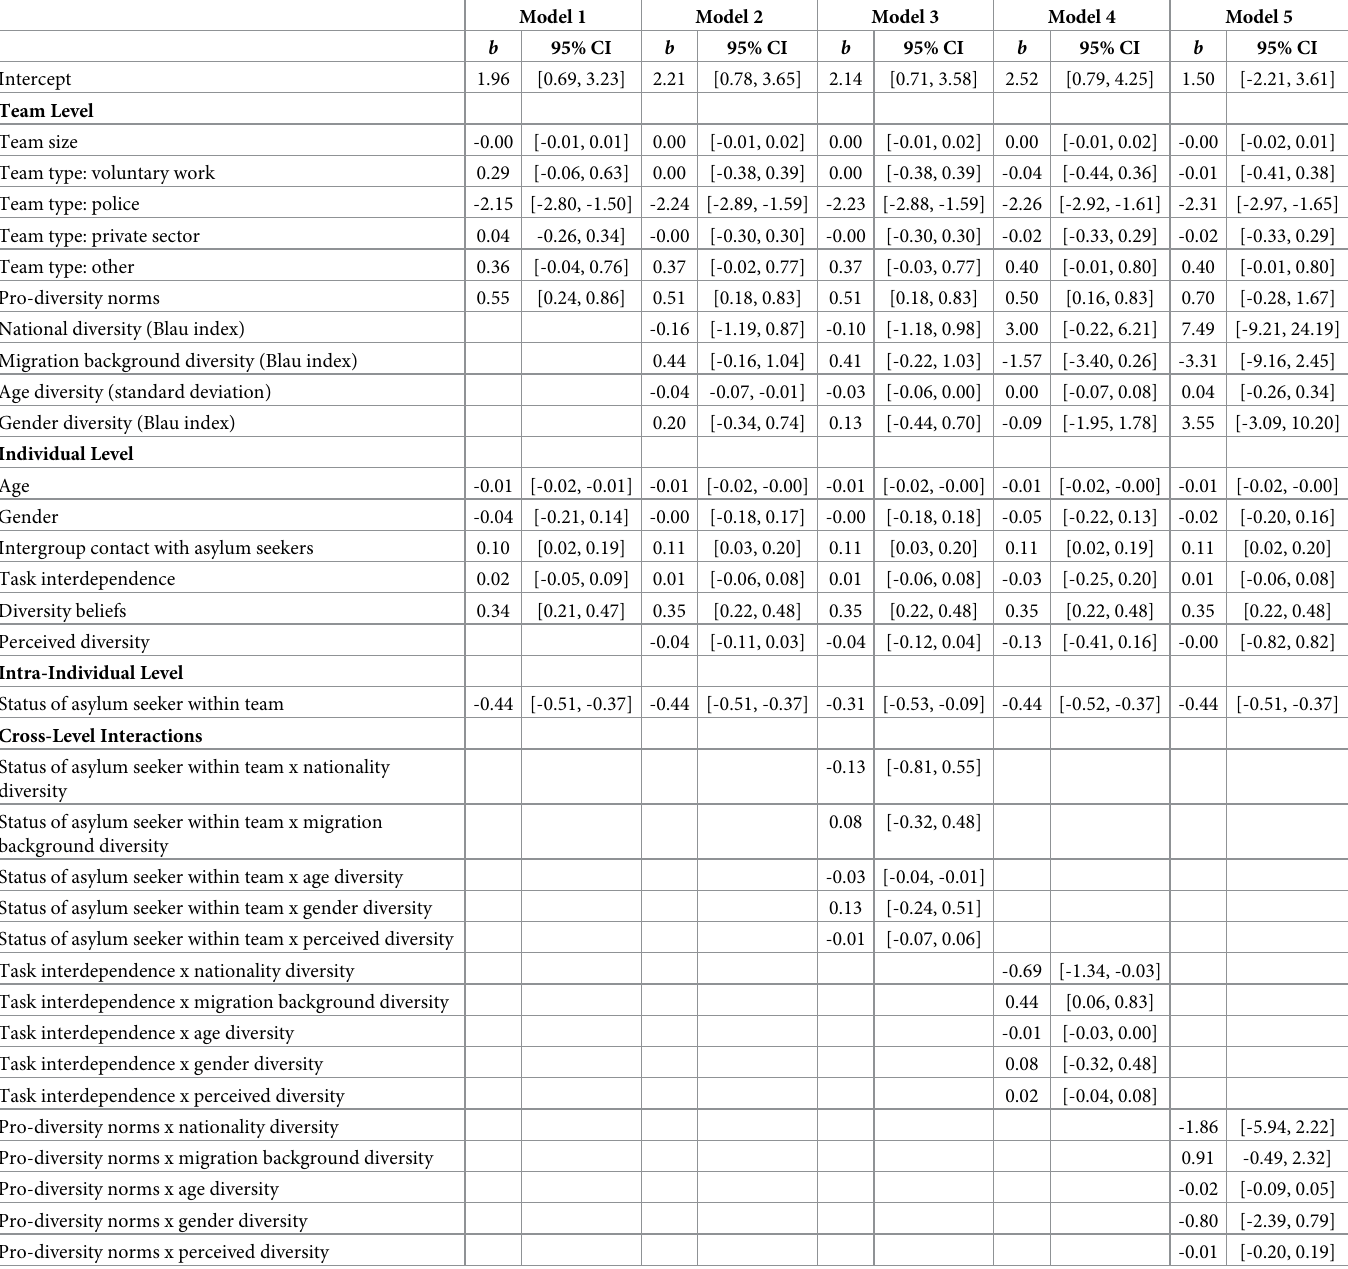
Table 2. Parameters in the estimated